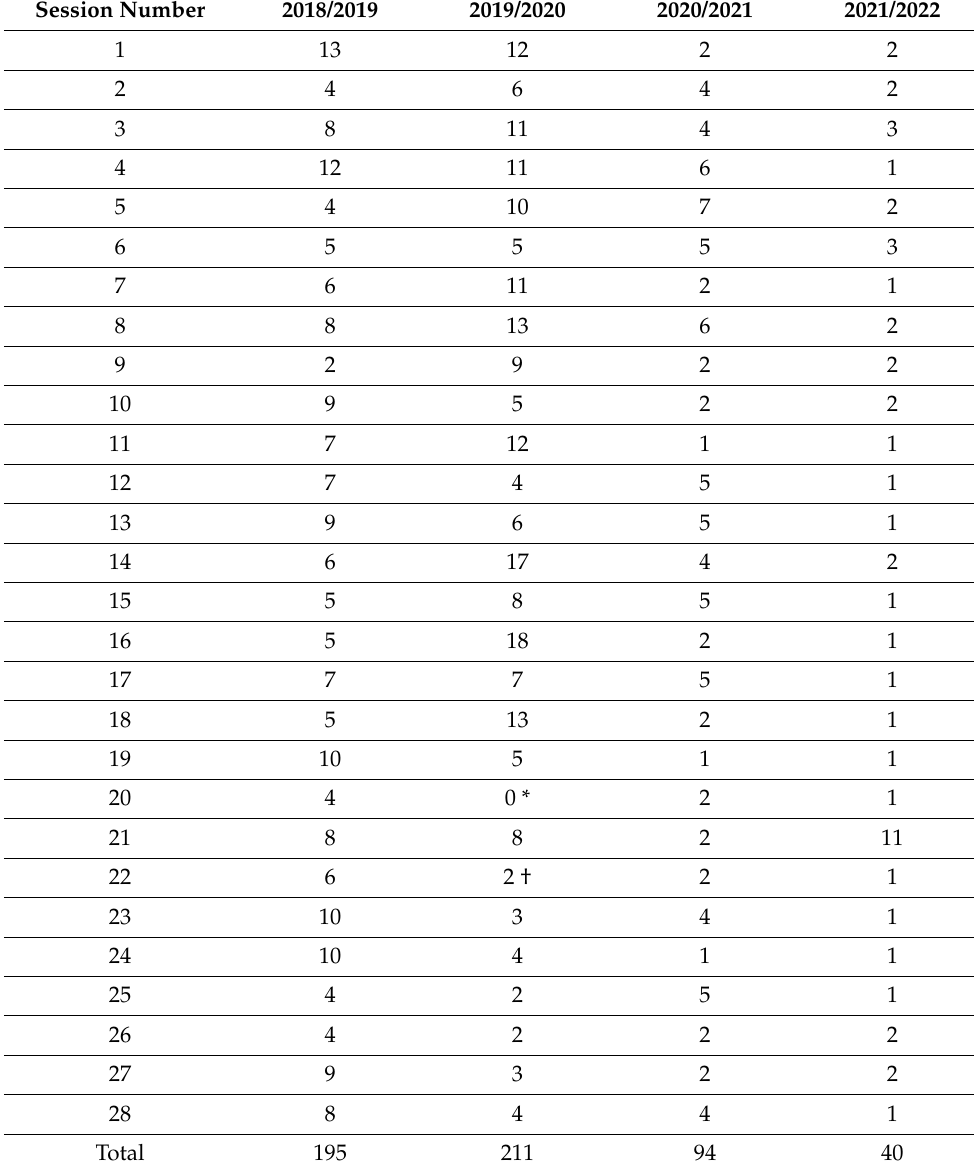
Table 2. Doodles Provided Over the Twenty-Eight Sessions of HeNReG Meetings during the Most Recent Four Years of the